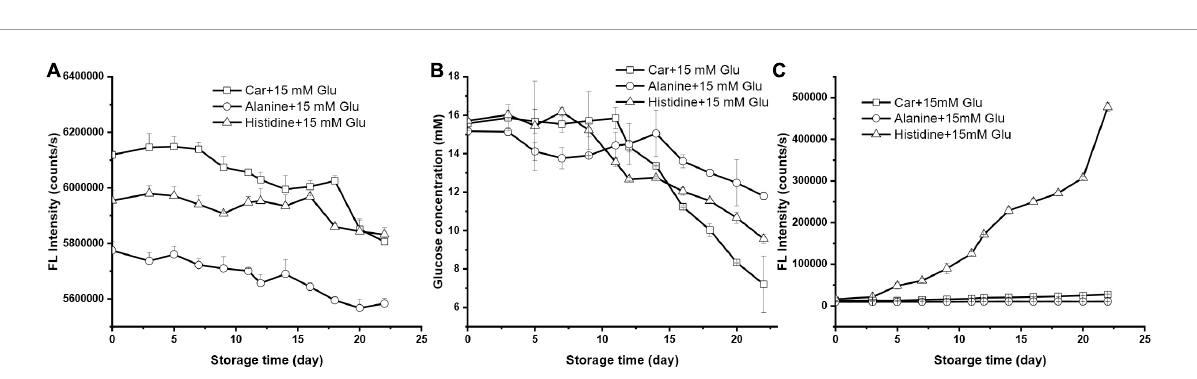
FIGURE3 The changes of (A) amino acids florescence intensity, (B) glucose concentration, and (C) the formation of MRP during storage (the initial mixture contained 10 mM carnosine, alanine, or histidine with 15 mM glucose).